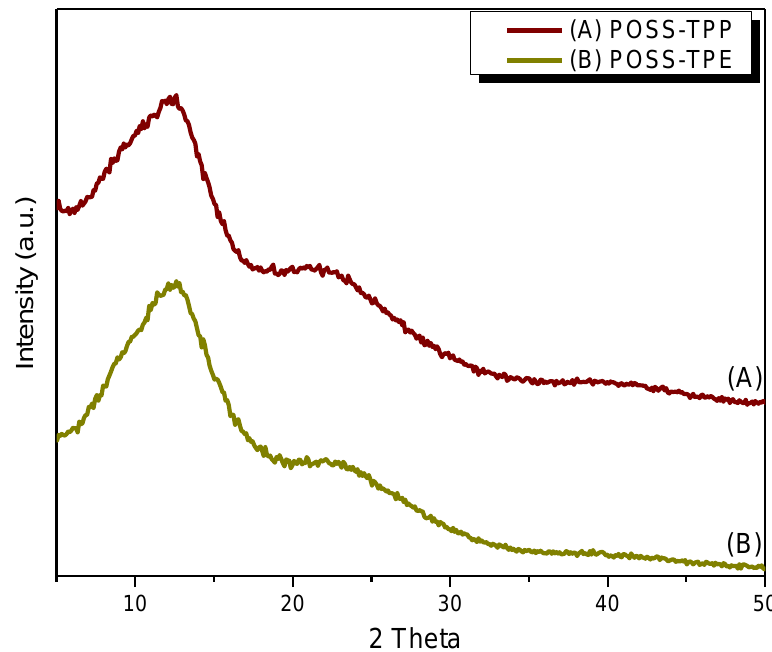
Figure 6. XRD pattern of (A) POSS-TPP and (B) POSS-TPE. Nitrogen adsorption – desorption experiments at 77 K were measured to examine the porosity parameters for our new POSS-TPP and POSS-TPE (Figure 7). Both of the nitrogen adsorption – desorption profiles of POSS-TPP and POSS-TPE (Figures 7A,B) revealed a rapid N 2 uptake at a low P/P 0 pressure that continued to increase at a high P/P 0 pressure, indicating the coexistence of mesopores and micropores in the hybrid polymer network. Based on the International Union of Pure and Applied Chemistry (IUPAC) classification for BET curves, both POSS-TPP and POSS-TPE featured type IV adsorption isotherms. In addition, there were the hysteresis loops in both curves which also confirmed the presence of micropores and mesopores in the polymer framework. The Brunauer – Emmet – Teller (BET) surface area and total pore volume of the POSS-TPP and POSS-TPE were calculated to be 270 m 2 /g and 0.22 cm 3 /g, respectively, for POSS-TPP and 741 m 2 /g, 0.58 cm 3 /g, re- spectively, for POSS-TPE. The pore size distributions of POSS-TPP and POSS-TPE were calculated by using non-local density functional theory (NL-DFT), as elucidated in Figures 7C,D. The pore size diameters of the POSS-TPP were 1.04 nm and 1.82 nm (Figure 7C), while the POSS-TPE featured pore size diameters at 1.08 nm and 2.09 nm (Figure 7D). The porosity parameters of the POSS-TPP and POSS-TPE are provided in Table 1. In addition, TEM images (Figure 7E,F and Figure S5) of the POSS-TPP and POSS-TPE featured a mi- croporous structure with no long-range order. The TEM results were consistent with the XRD pattern (Figure 6).